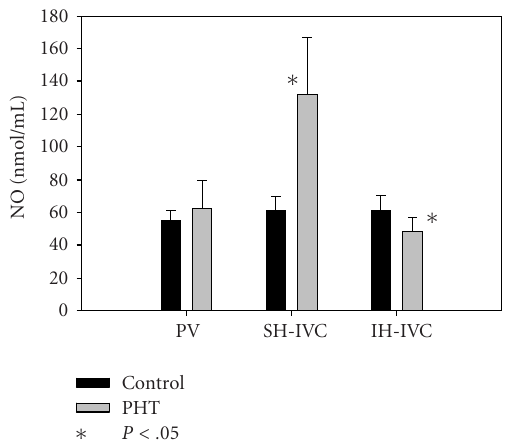
Figure 5. Carbon monoxide (CO) in portal vein (PV), supra- hepatic inferior vena cava (SH-IVC), and infrahepatic inferior vena cava (IH-IVC) in control rats (Group I) and in rats with triple stenosing ligation of portal vein (TSLP) (Group IIb) after 28 days of